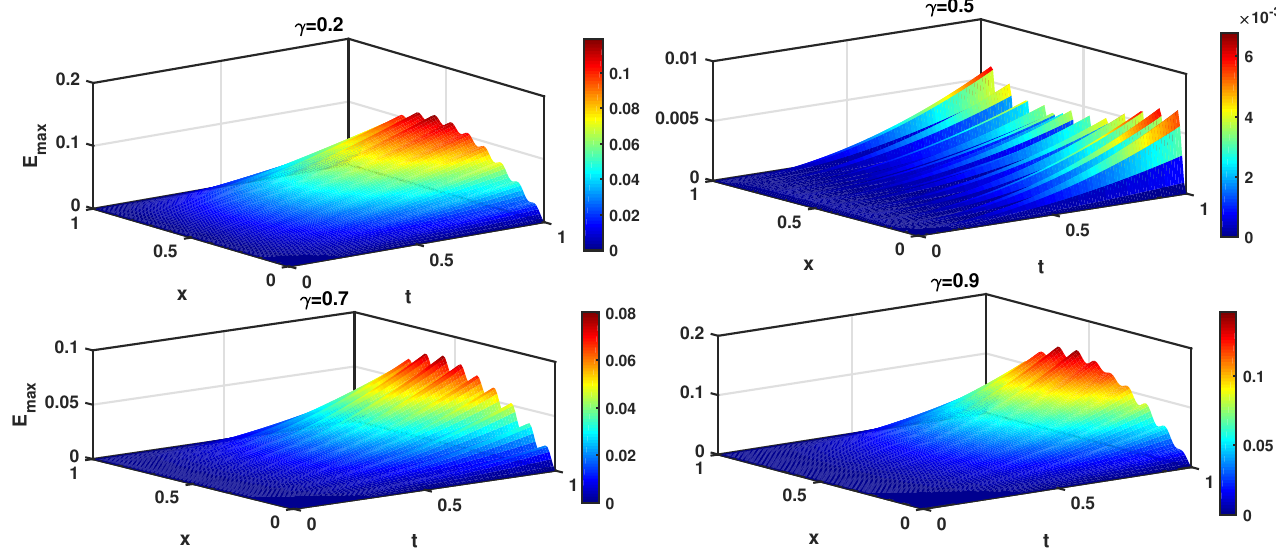
Figure 14. Evolution of the E max with respect to γ for Example 4 at T = 1 where τ = 0.01, ν = 1, M = 52, N = 22, and K =